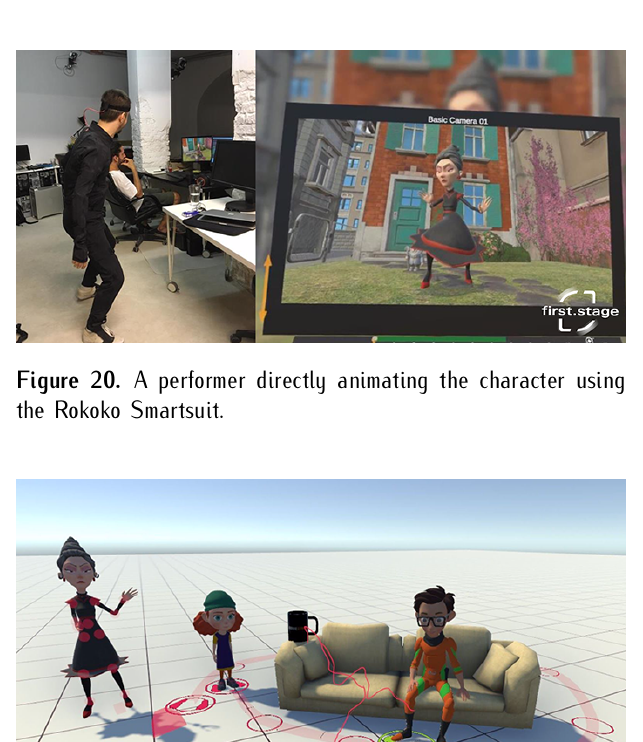
Figure 19. Puppets can be posed by adjusting the attached handles to their body parts.